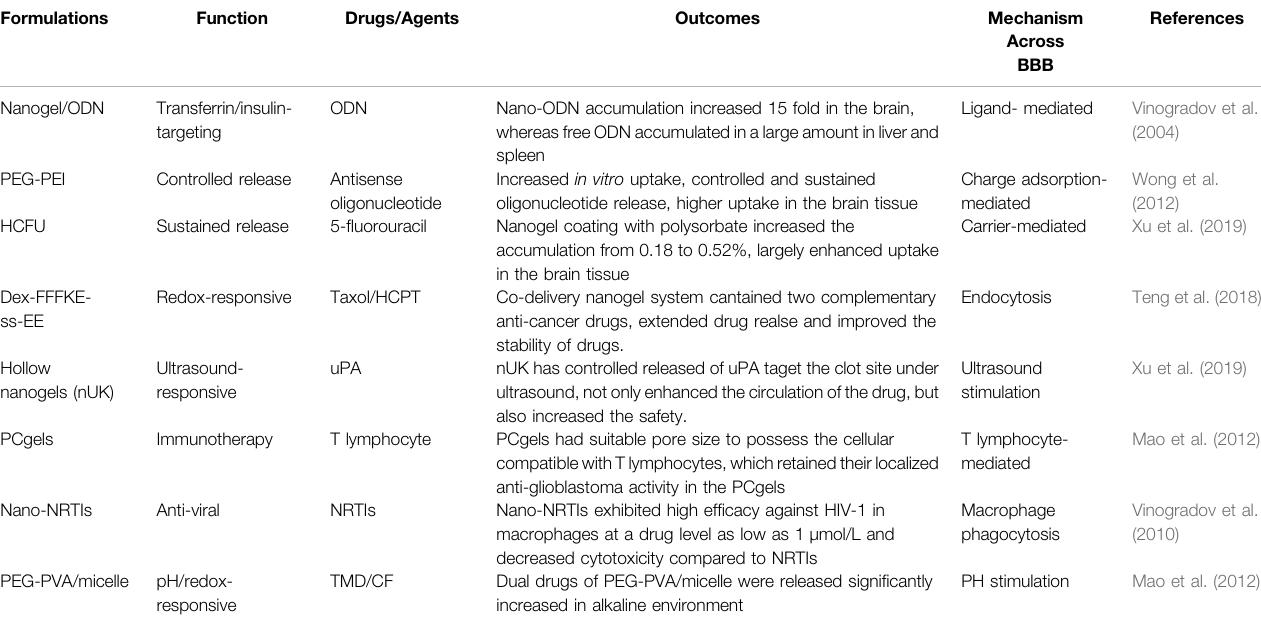
TABLE 3 | Summary of representative studies on nanogels for CNS drug delivery.